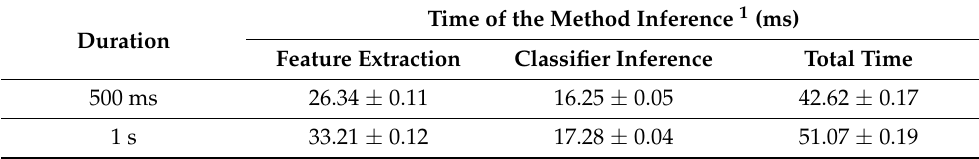
Table 11. The inference time for different duration of ECG